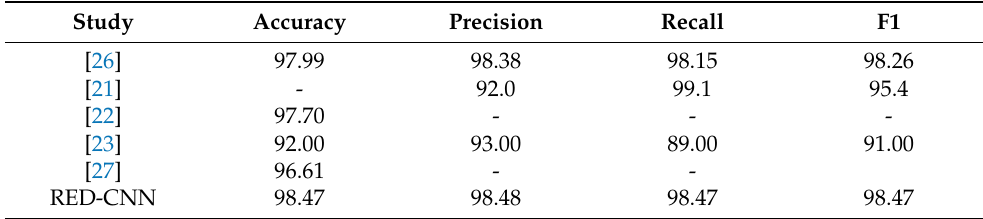
Table 5. Comparison of RED-CNN with other studies based on tuberculosis (TB) chest X-ray database .